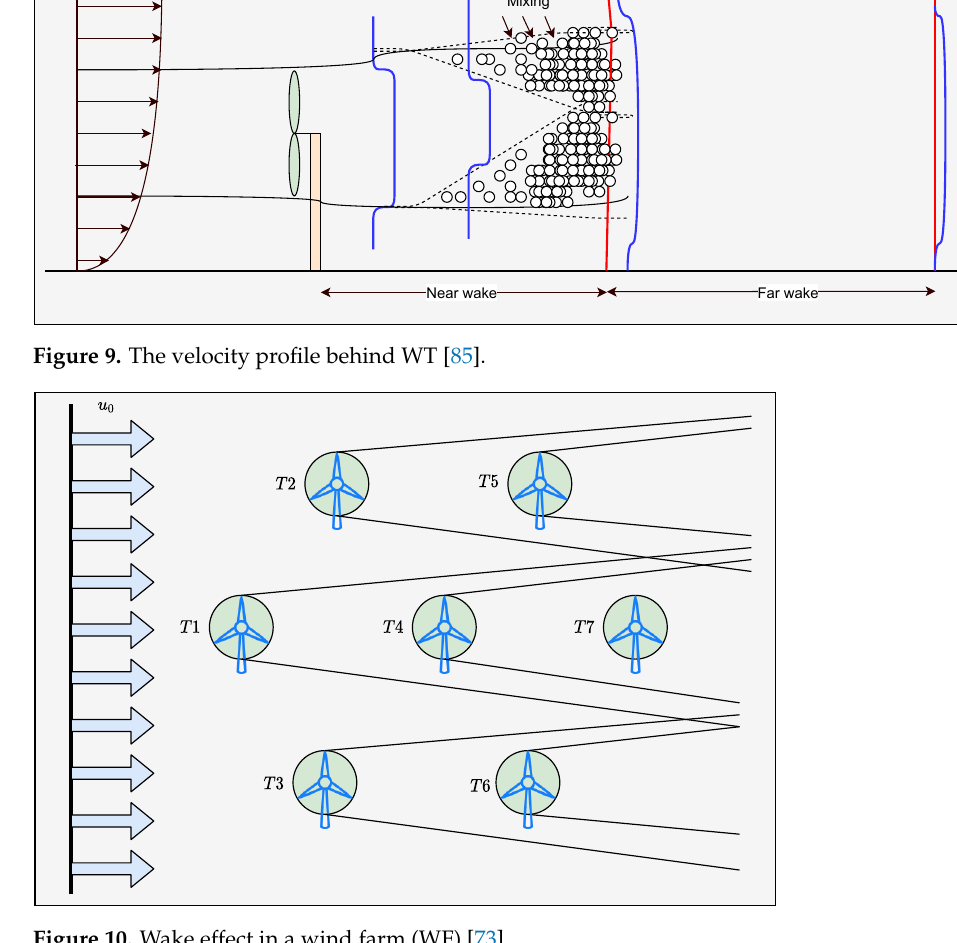
Figure 10. Wake effect in a wind farm (WF)